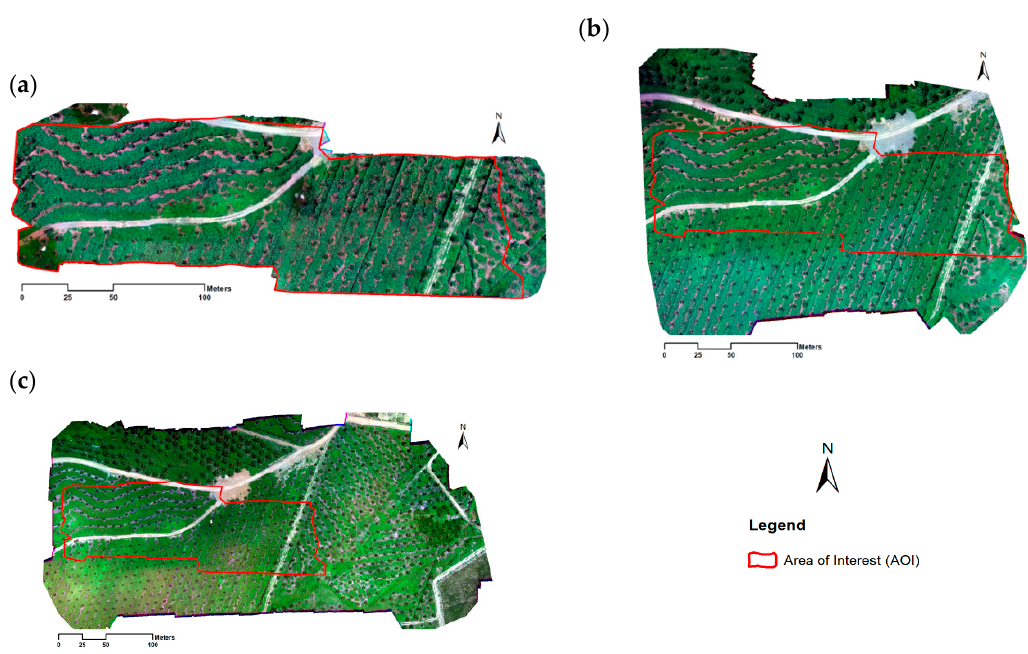
Figure 5. Multispectral orthomosaic aerial images in (RGB) true color composites at a flight altitude of ( a ) 20 m, ( b ) 60 m, and ( c ) 80 m with AOI overlay.